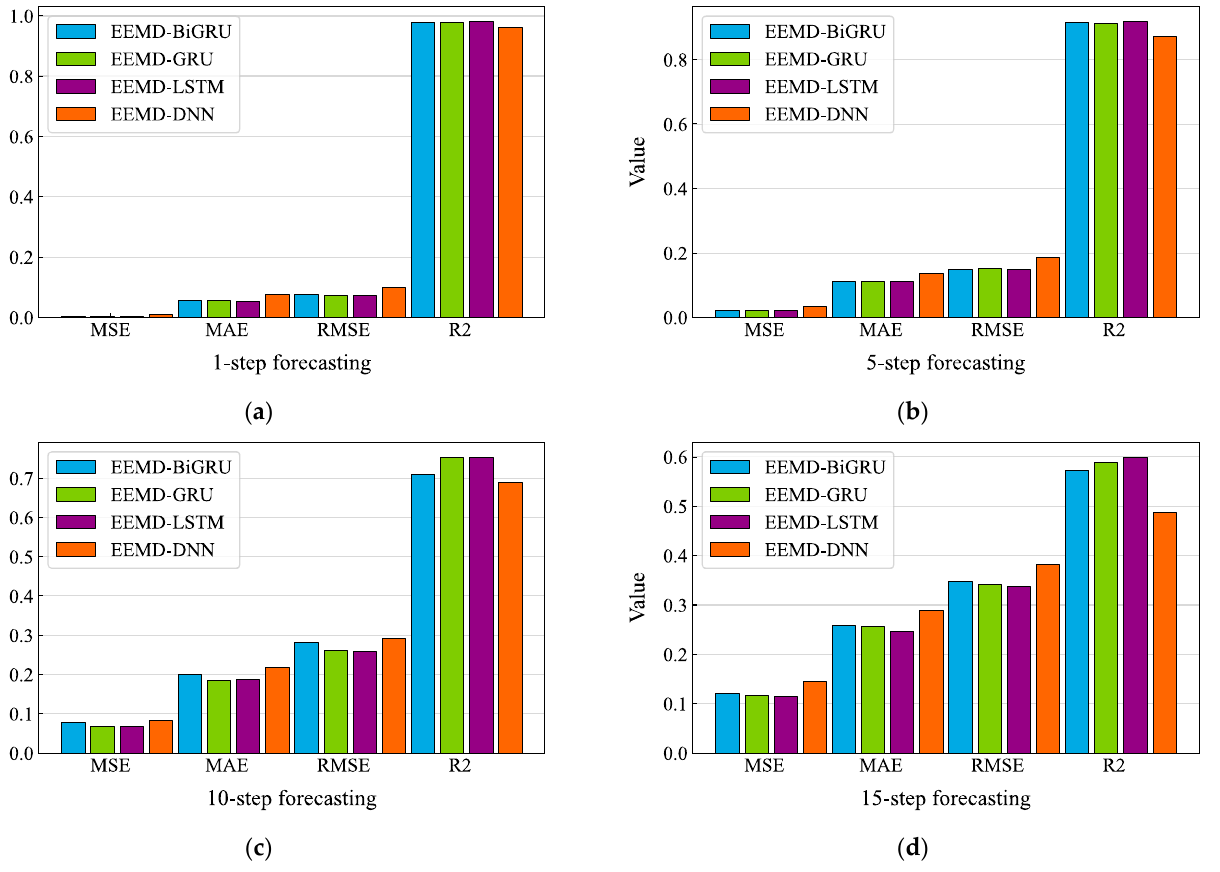
Figure 15. Evaluation metric comparisons results for the white dataset using the EEMD-based algorithms: ( a ) 1-step forecasting of the four hybrid models; ( b ) 5-step forecasting of the four hybrid models; ( c ) 10-step forecasting of the four hybrid models; ( d ) 15-step forecasting of the four hybrid models.